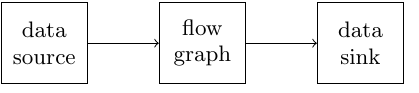
Figure 3: Structure of our SDR interface.